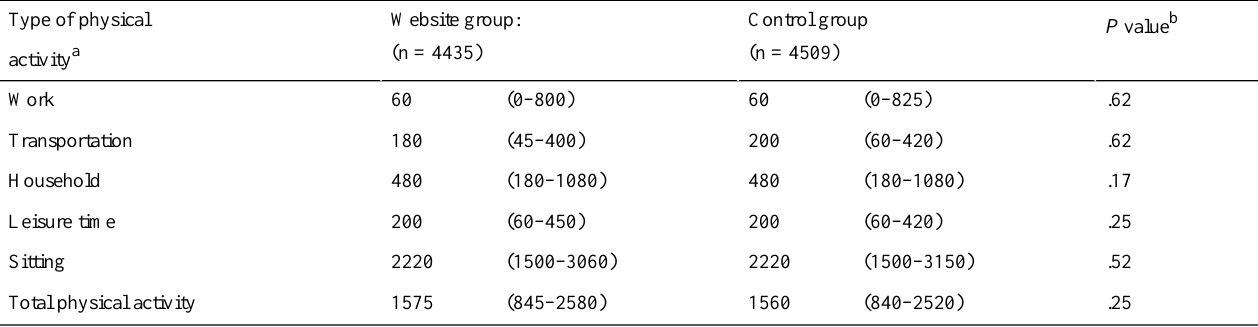
Table 4. Physical activity assessed by International Physical Activity Questionnaire (min/week) at 6-month follow-up by website and control group (intention-to-treat analysis) (Denmark, 2008).